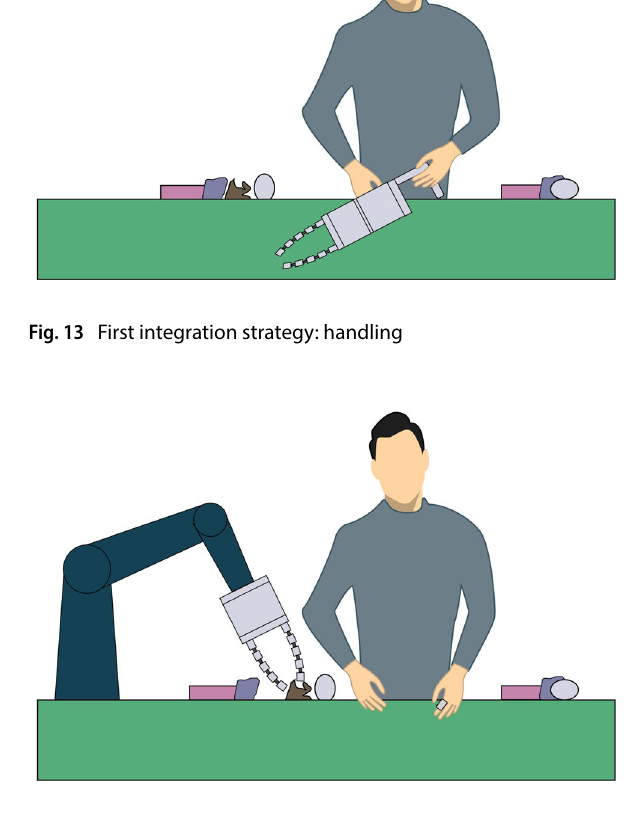
Fig. 14 Second integration strategy: cobot